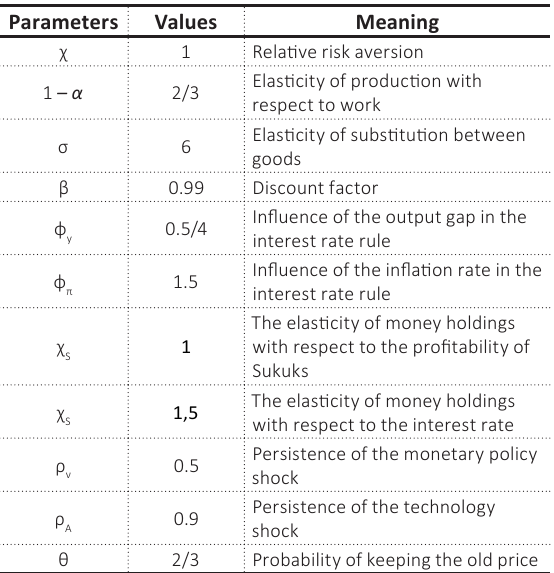
Table 1. Calibration of the model